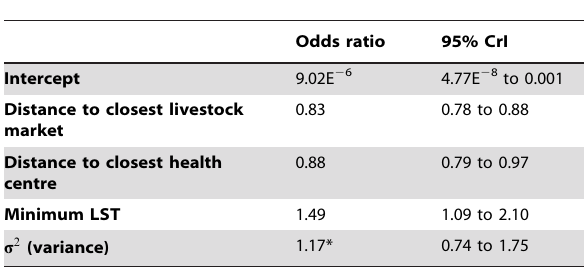
Table 2. Odds ratios and 95% credible intervals from Bayesian multivariate regression